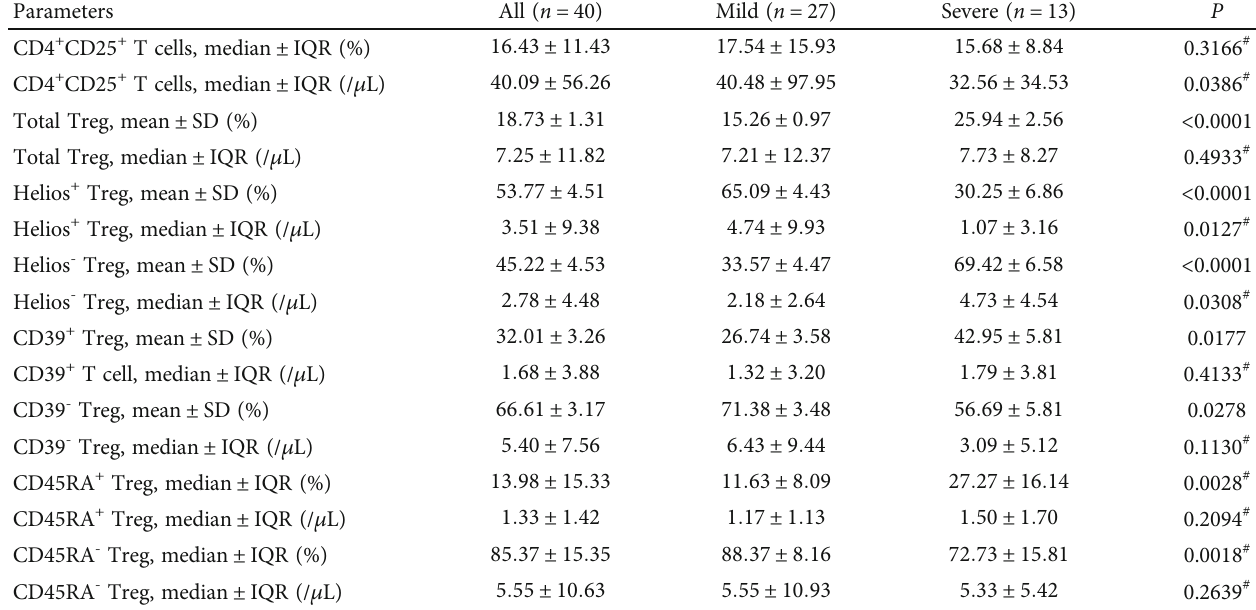
Table 4: Treg subset panel of the